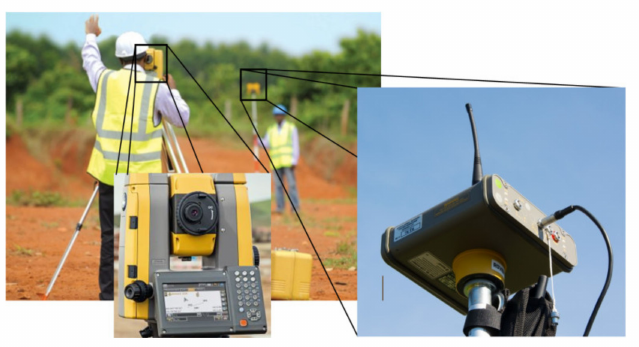
Figure 3. Survey experimental